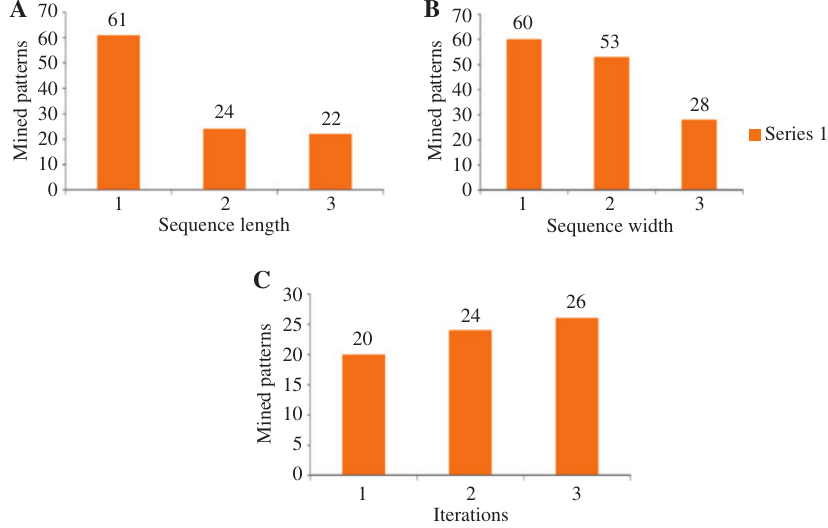
Figure 2: Number of Patterns Mined from Dataset 1. (A) By varying length. (B) By varying width. (C) By varying iterations.